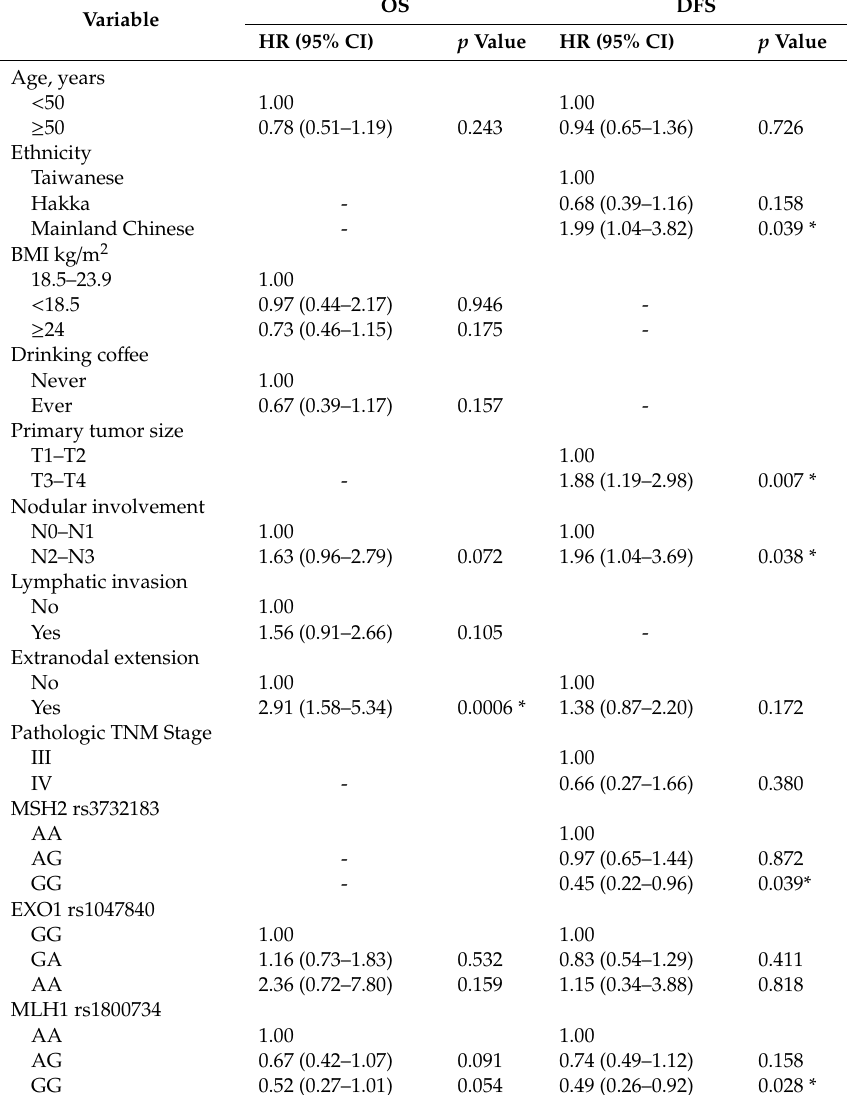
Table 4. Multivariate association between polymorphisms of MMR pathway genes and survival in patients with OSCC receiving adjuvant concurrent